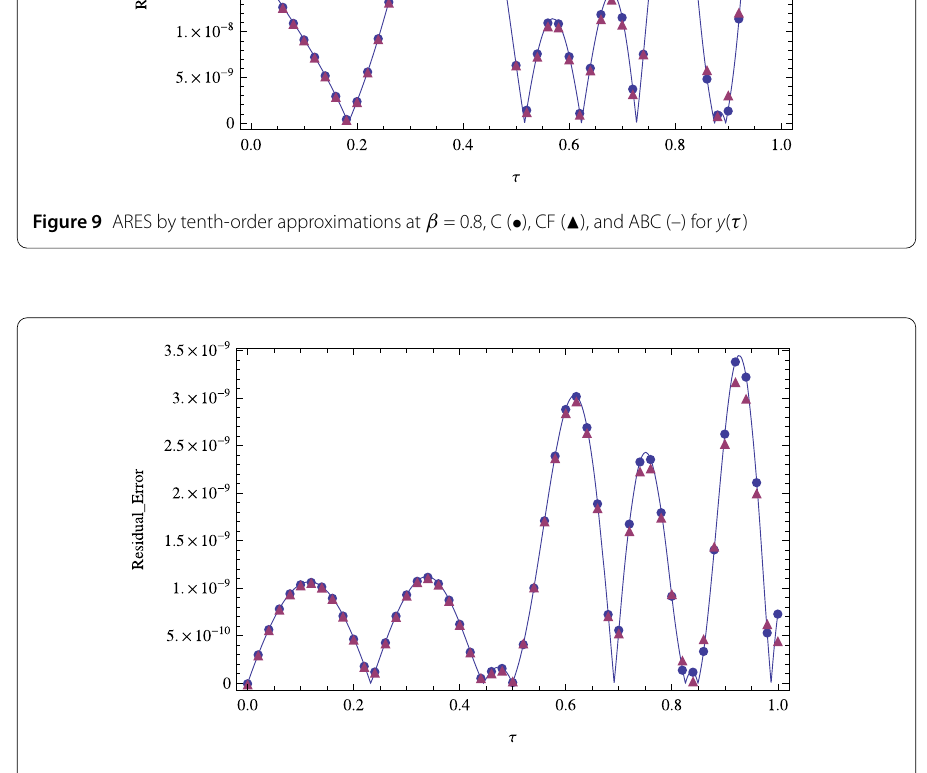
Figure 10 ARES by tenth-order approximations at β = 0.8, C ( • ), CF ( (cid:2) ), and ABC (–) for z ( τ )